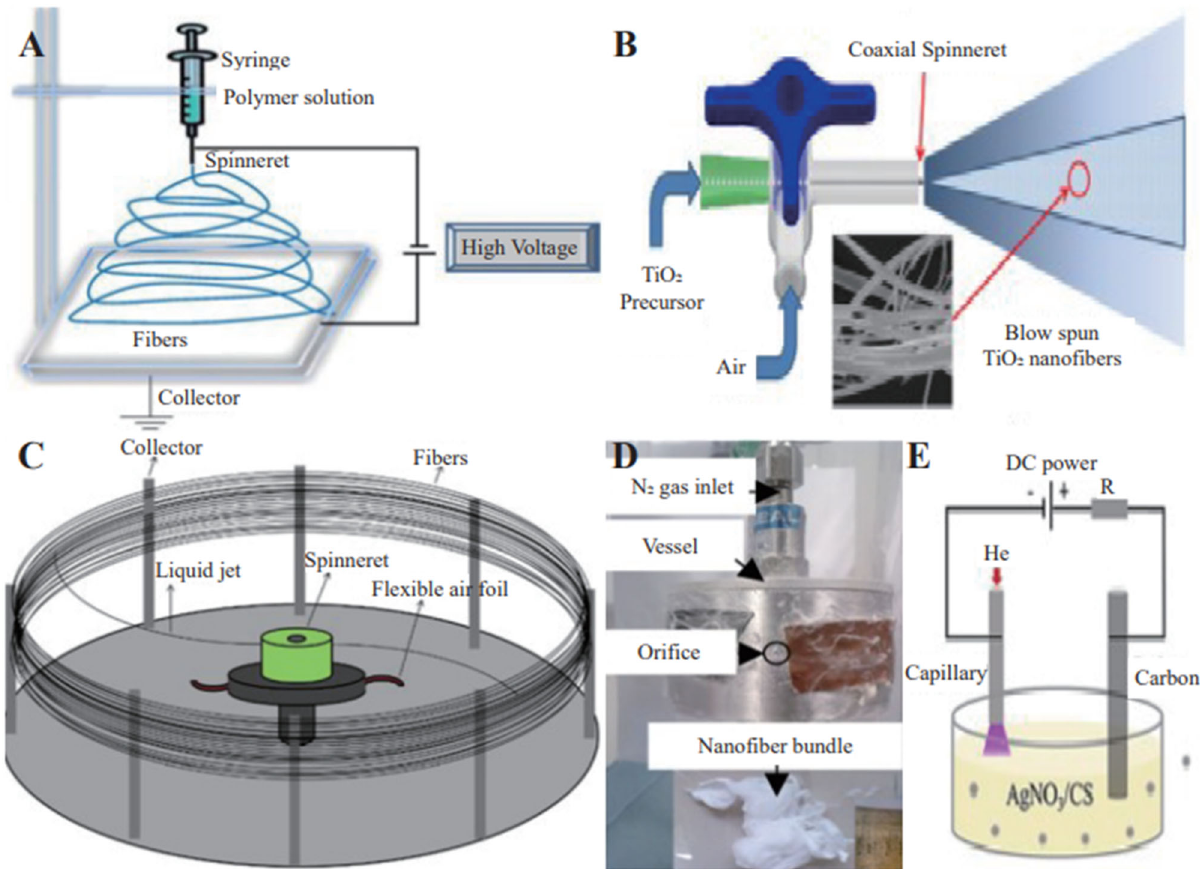
Fig. 1 Common preparation methods of polymeric nano fi bers. electrospinning system ( A ) [149]; Pressurized gyration system ( B ) [150]; centrifugal spinning system ( C ) [151]; pressurized gyration system ( D ) [69]; plasma-induced synthesis system ( E )